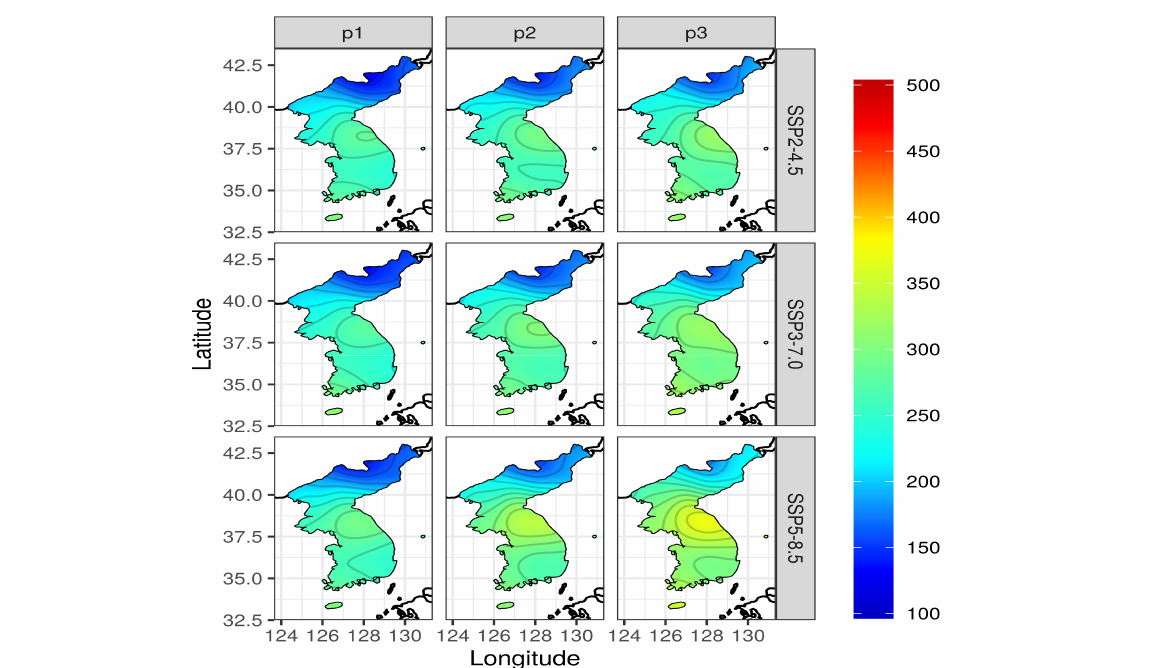
Figure 8. Isopluvial maps of the 20-year return levels (unit: mm) of the annual maximum daily precipitation for 46 grids over the Korean peninsula for the future periods: P1 (2021–2050), P2 (2046–2075), and P3 (2071–2100) under the SSP2-4.5, SSP3-7.0, and SSP5-8.5